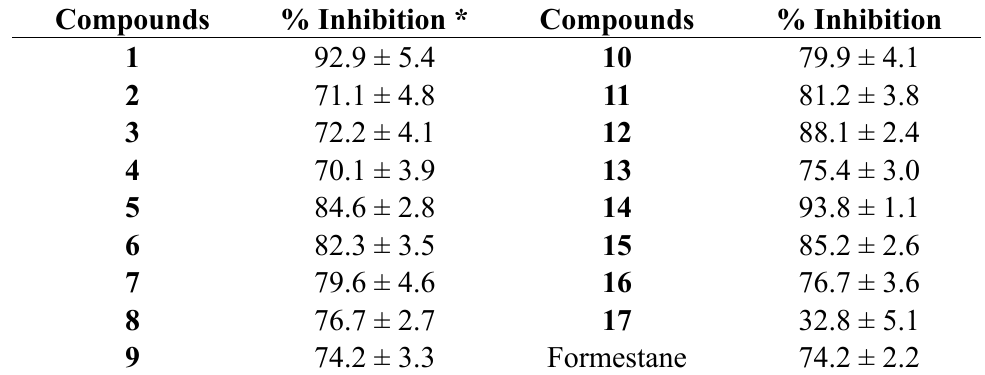
* All incubations were carried out with 100 nM inhibitor and 0.25 μ M [1 β -3H]androstenedione for least three independent experiments done in